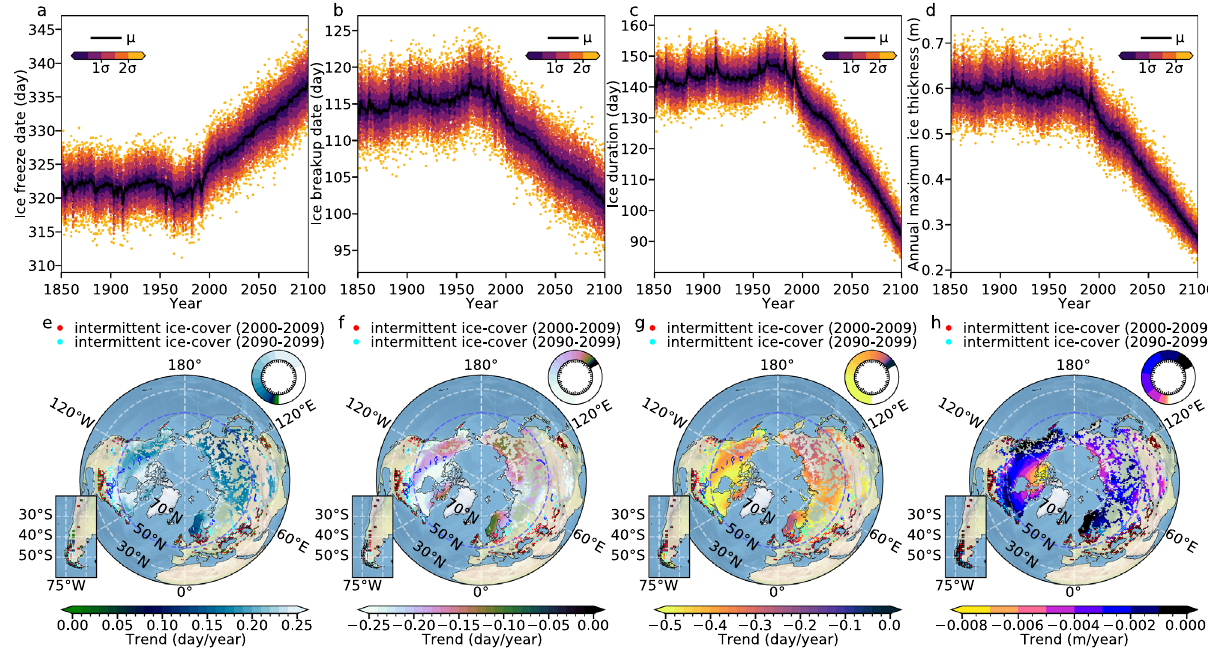
Fig. 1 | Projections of lake ice phenology and thickness. Timeseries of lake-area weightedglobalmeanicefreezedate( a ),icebreakupdate( b ),durationoficecover ( c ),andmaximumicethickness( d )ineachyearintheCESM2-LEsimulations.Black lines represent the 90-member ensemble mean ( μ ). Shaded bands indicate the standarddeviations( σ )acrossensemblemembers(circles).The y axesin( a )and( b ) represent the day of the year. e – g are the patterns of the temporal trends of the ensemble mean for ice freeze date, ice breakup date, and ice duration during 2000 – 2100, respectively. Intermittent frozen lakes (de fi ned as at least one winter